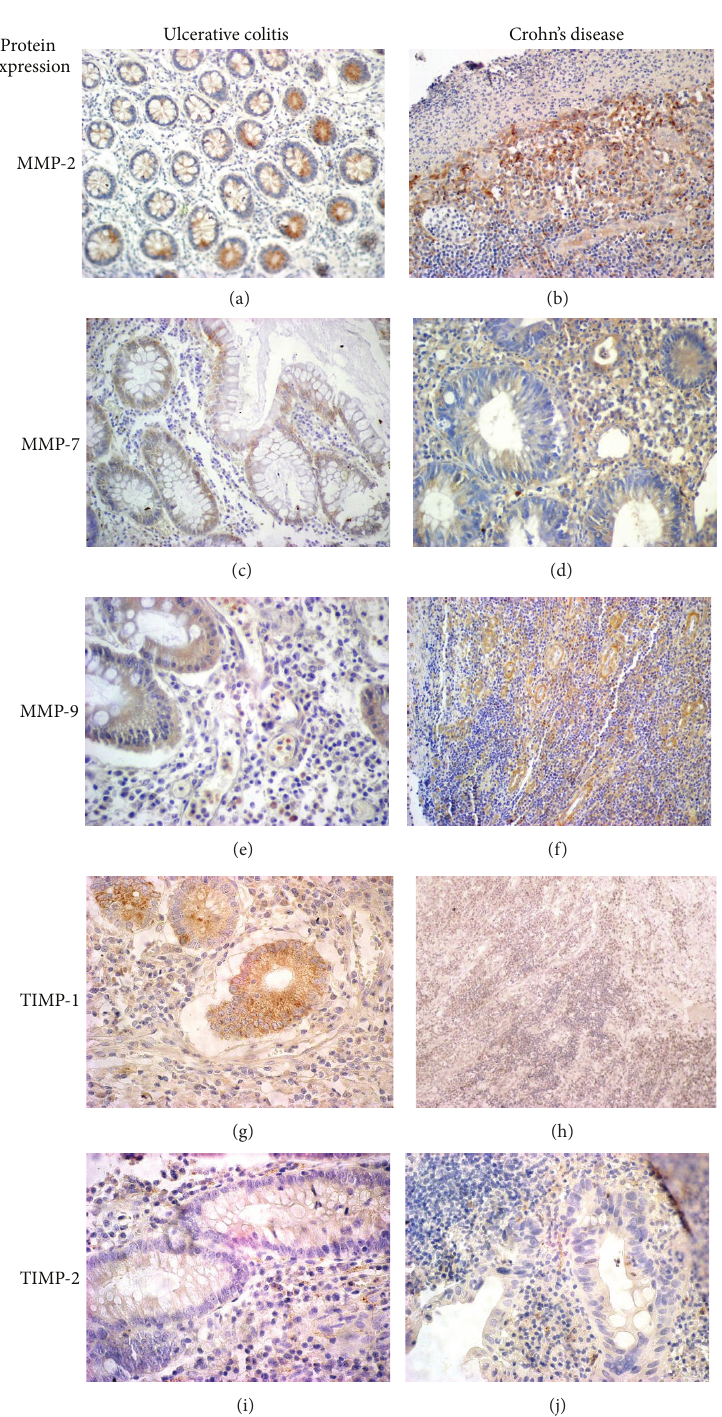
Figure 1: Immunohistochemical expression of MMP-2, MMP-7, MMP-9, TIMP-1, and TIMP-2 in glandular tubes and inflammatory cells in tissues of ulcerative colitis ( 𝑁 = 34 ) and Crohn’s disease ( 𝑁 = 10 ). MMP-2 expression was weak in glandular tubes in patients with UC and positive reaction of this protein in inflammatory cells of CD (a, b). The positive expression of MMP-7 in glandular cells in both diseases, but there is more frequent expression observed in stroma of CD (c, d). Moreover, MMP-9 reaction was strong positive in glandular epithelium of UC and moderate in the stromal cells of CD patients (e, f). The strong expression of TIMP-1 in glandular cells and inflammatory infiltrate in both diseases compared to lack of or weak reaction of TIMP-2 protein (g, h, i, and